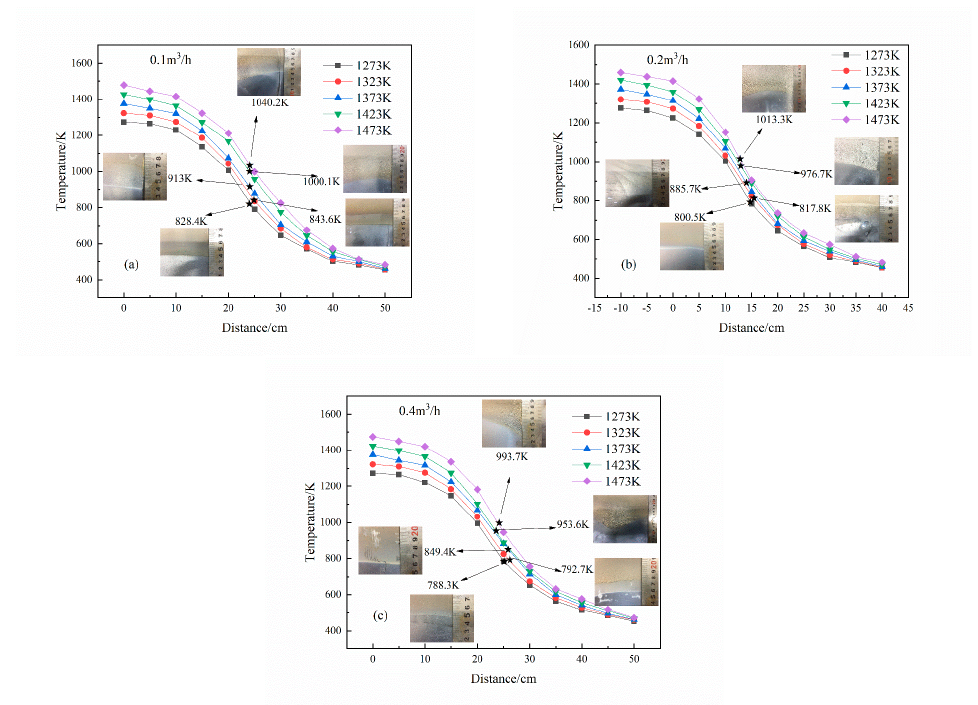
Figure 4. Relationship between temperature distribution and condensation position: ( a ) 1273–1473 K heating and 0.1 m 3 /h Ar, ( b )1273–1473 K heating and 0.2 m 3 /h Ar, ( c )1273–1473 K heating and 0.4 m 3 /h Ar.